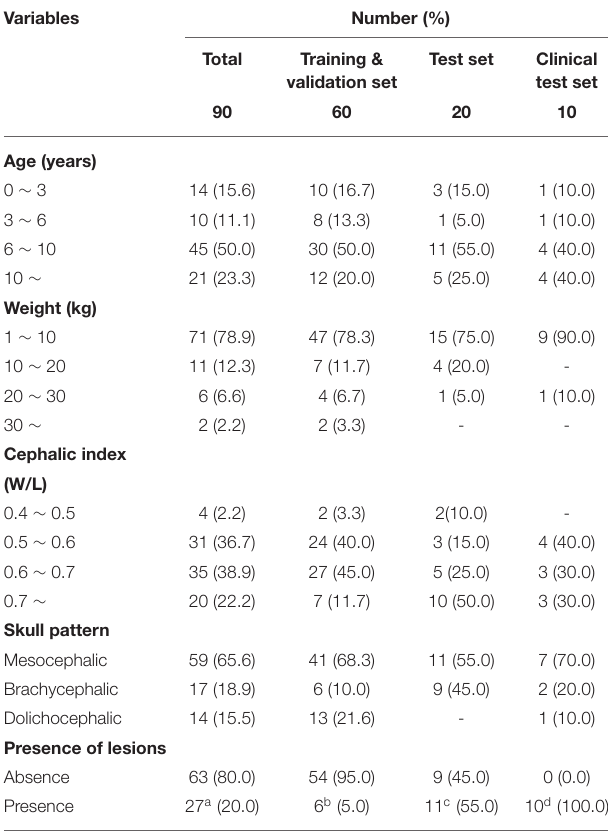
TABLE 1 | Distribution of numbers and proportions according to